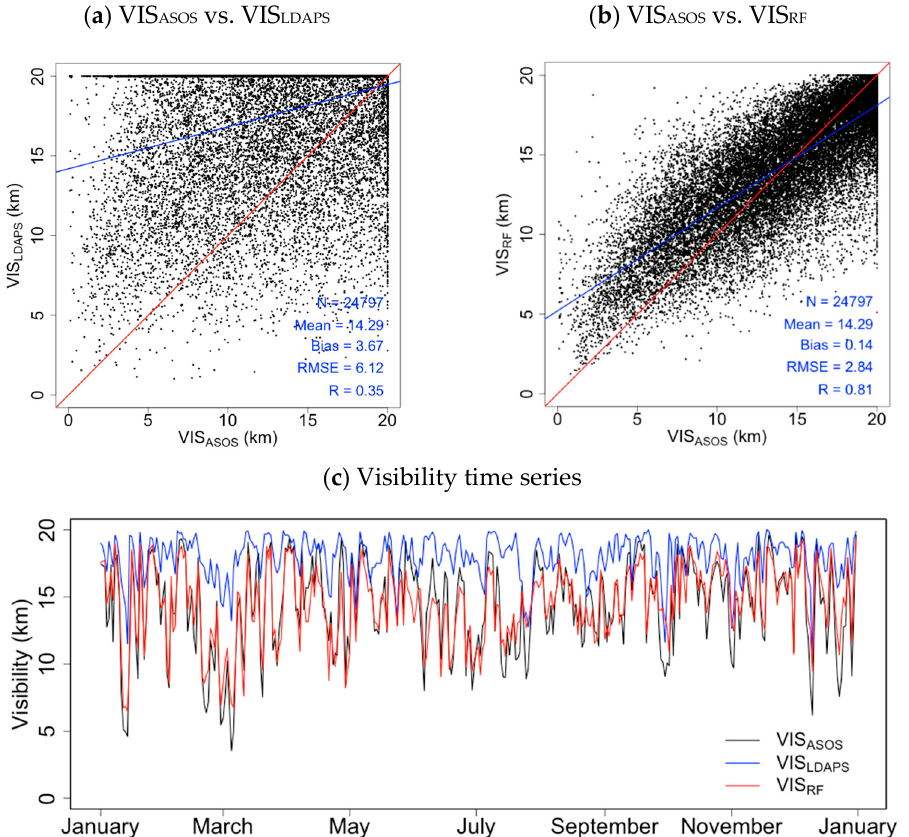
Figure 5. Scatter ( a , b ) and time-series ( c ) plots of VIS ASOS , VIS LDAPS , and VIS RF in 2019. The red lines represent the 1:1 line, and the blue lines represent the regression line.